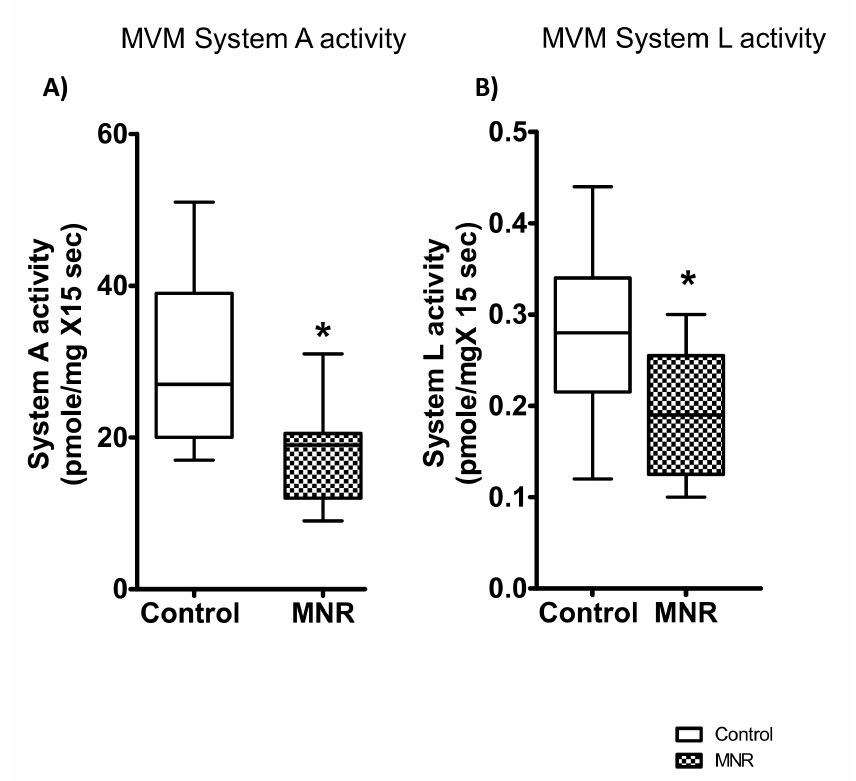
Figure 5. MVM System A and L transport activity. ( A , B ) Microvillous plasma membrane vesicles (MVM) system A and system L activity in the MNR and control group. ( A ) System A mediated MeAIB uptake in MVM isolated from control and MNR placentas of baboons at GD 140. ( B ) System L mediated L-leucine uptake in MVM isolated from control and MNR placentas of baboons at GD 140. MVM system A and L uptake in Control and MNR groups were compared using the Mann–Whitney test ( n = 9/each group, * p < 0.05, mean ± S.E.M.). Medians ± IQR, n = 10 control; n = 12 MNR. KS normality test p -value: MVM system A activity (Control, p > 0.10; MNR, p > 0.10; passed normality), MVM system L activity (Control, p > 0.10; MNR, p > 0.10; passed